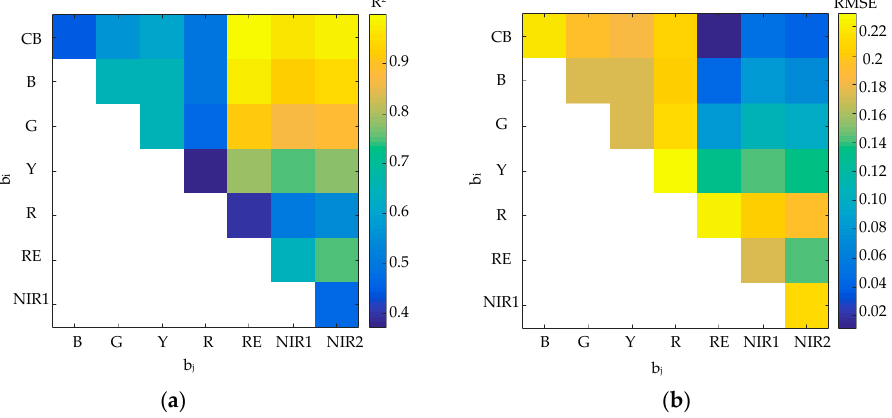
Figure 12. OBA-NDWI for the synthetic WV-3 spectra; all possible combinations of spectral bands are considered in the structure of NDWI to perform a second-order regression against water fractions. Values of ( a ) R 2 and ( b ) RMSE are represented by color bars.